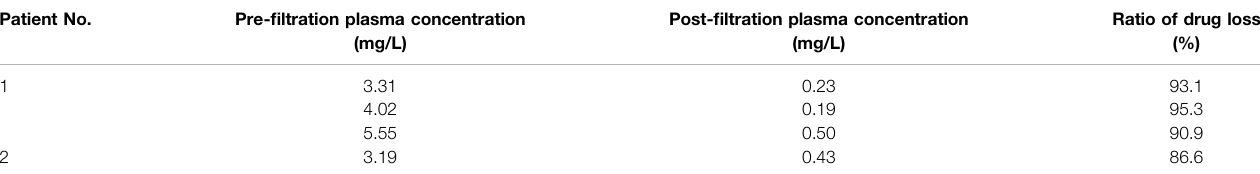
TABLE 2 | Concentration of polymyxin B of pre fi lter and post fi lter at 0.5 h after infusion during CRRT. Patient